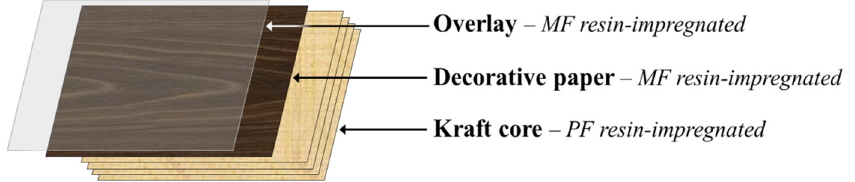
Figure 1. Typical assembly for a high pressure laminates build ‐ up.